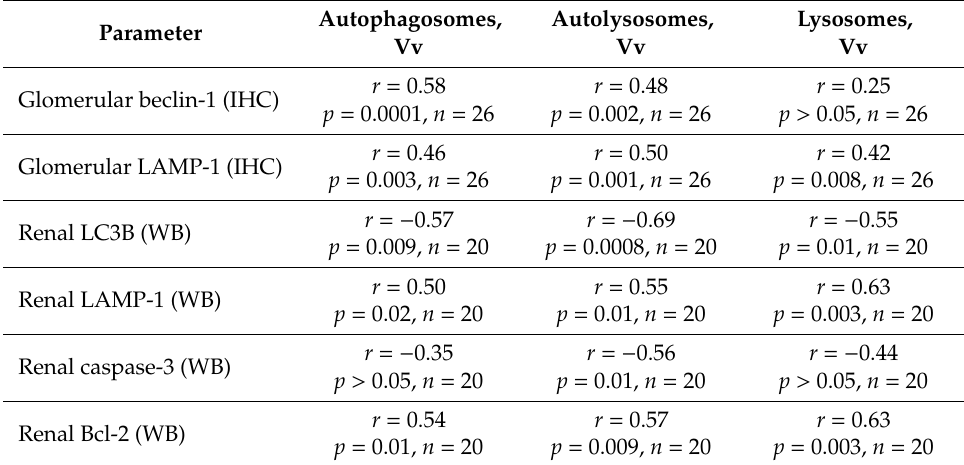
Table 6. Relationships between renal autophagy and apoptosis markers and Vv of autophagic compartments in